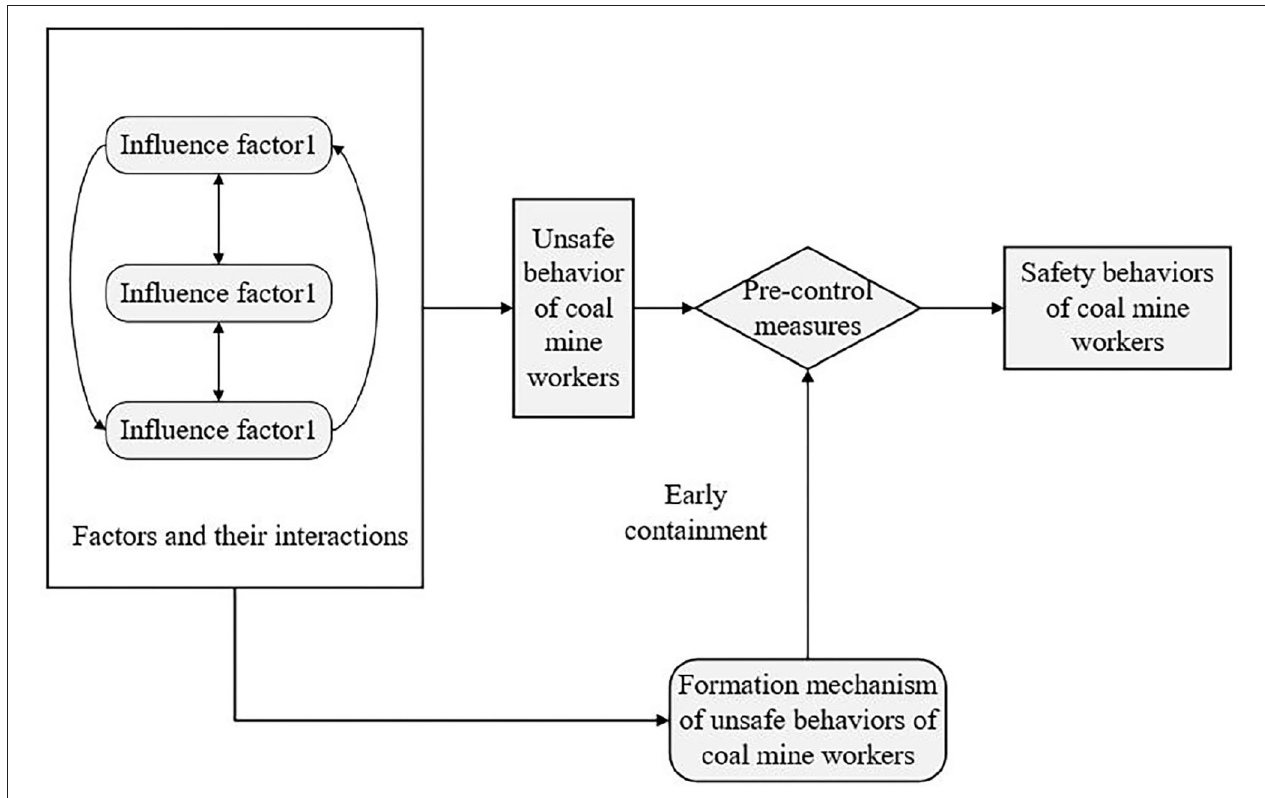
FIGURE 5 | The research framework in the studied